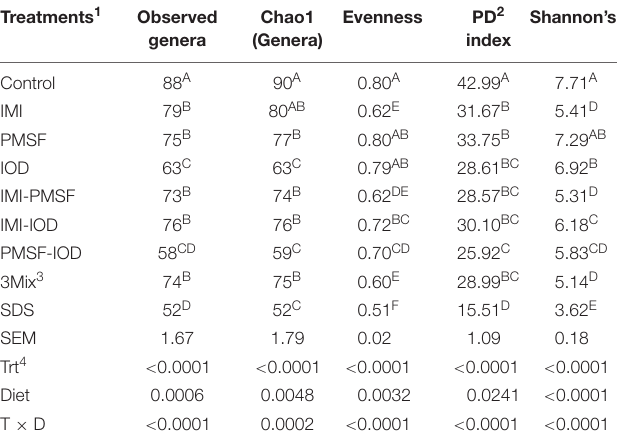
TABLE 2 | Alpha-diversity measurements of the microbiota (at 24 h of